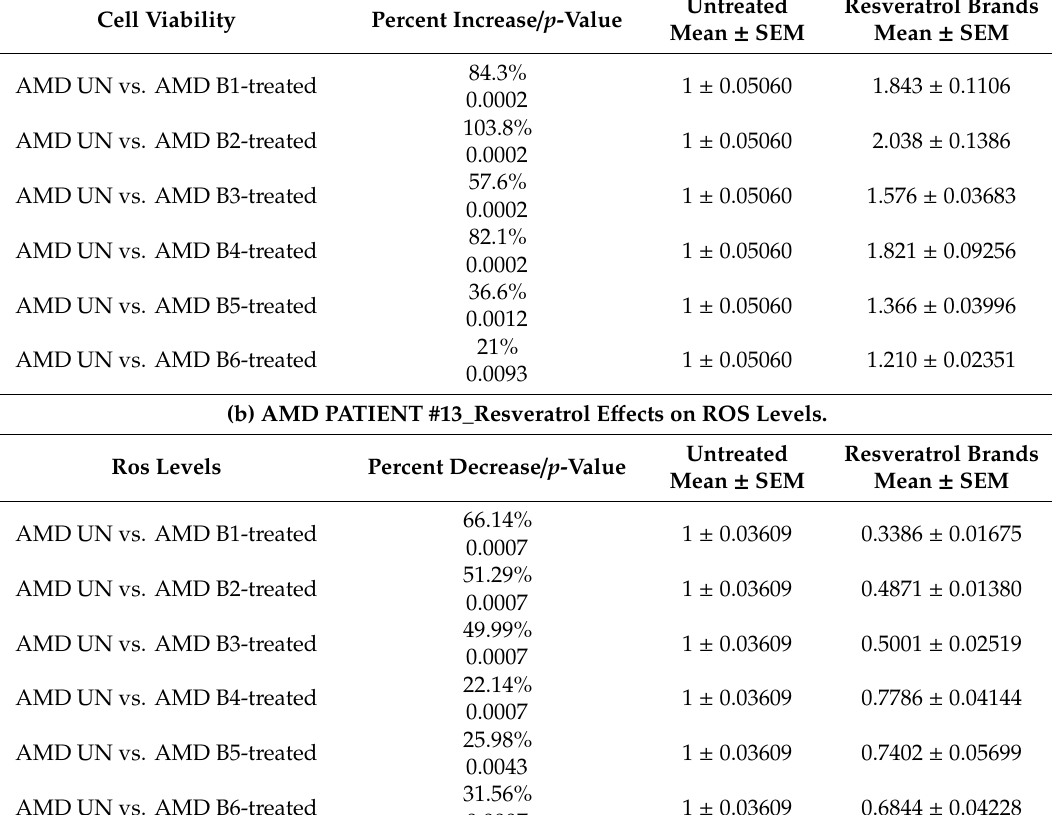
Table 15. E ff ects of resveratrol formulations on cell viability ( a ) and ROS levels ( b ) in AMD patient # 13. (a) AMD PATIENT #13_Resveratrol E ff ects on Cell